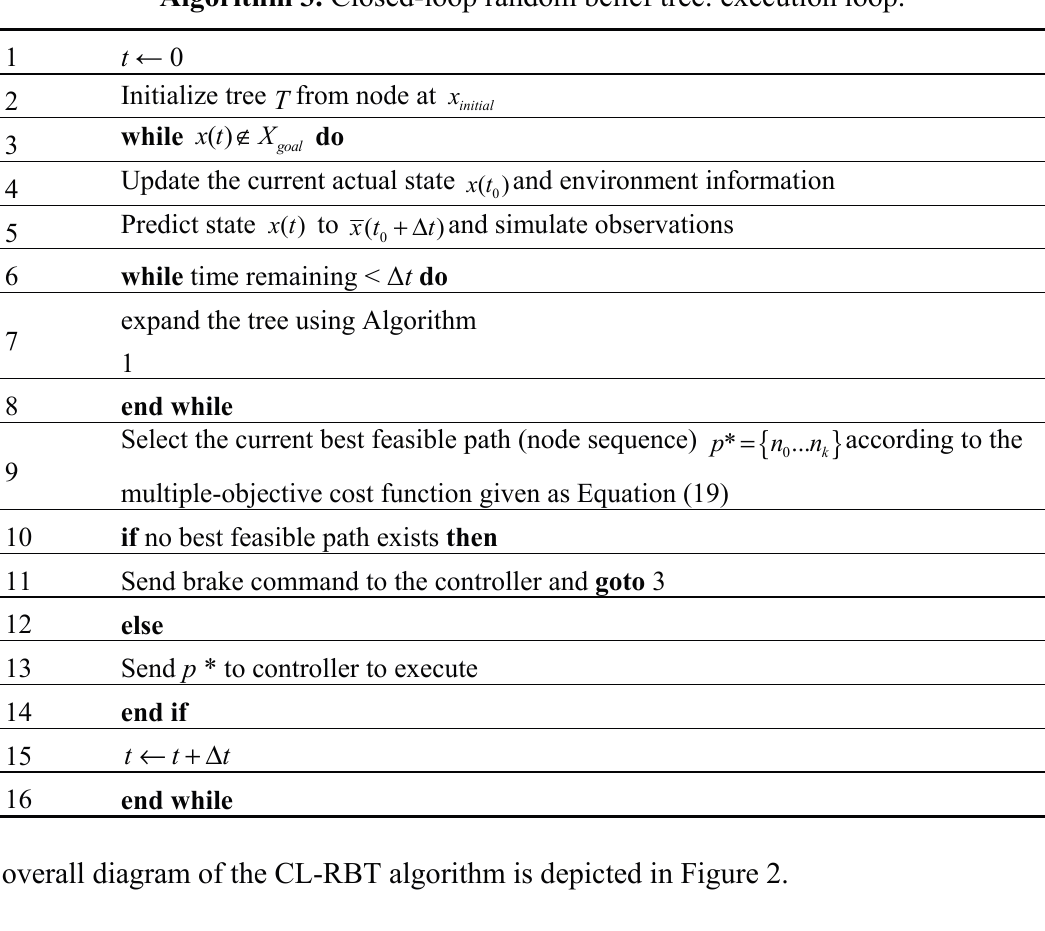
Figure 2. Diagram of the closed-loop random belief tree motion planning framework. MAV, micro-aerial